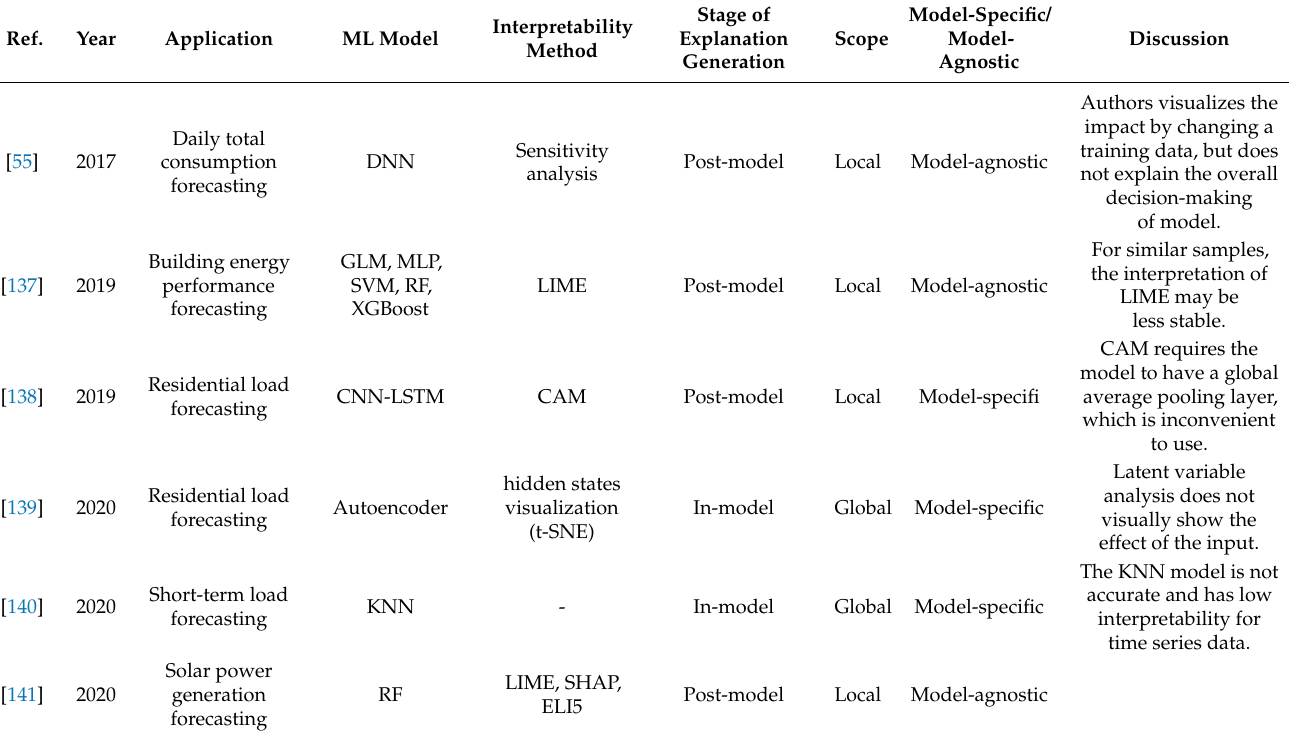
Table 4. Summary of interpretable ML for energy